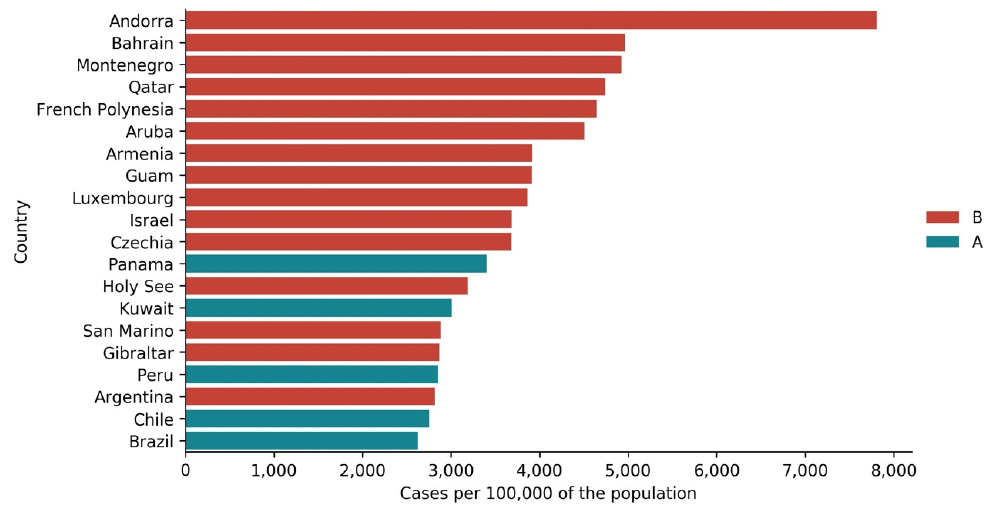
Figure 8. Top 20 of countries according to total cases by 100,000 of the population at Day 250 (color indicates the cluster each country belongs to).